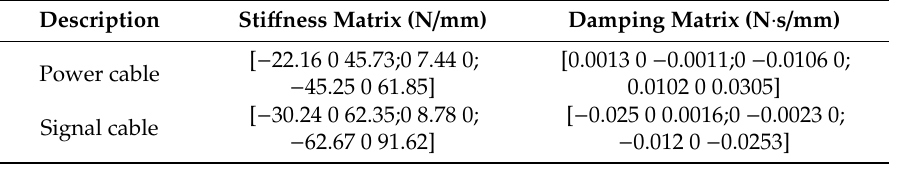
Table 3. Equivalent stiffness matrix and damping matrix of cables.